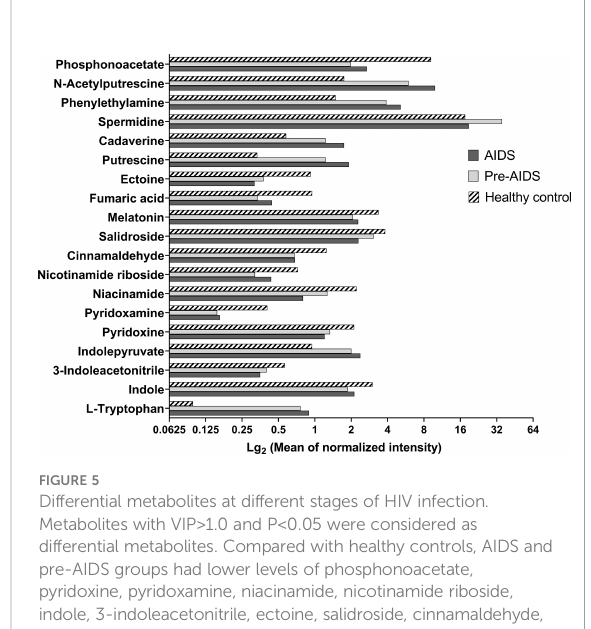
FIGURE 5 Differential metabolites at different stages of HIV